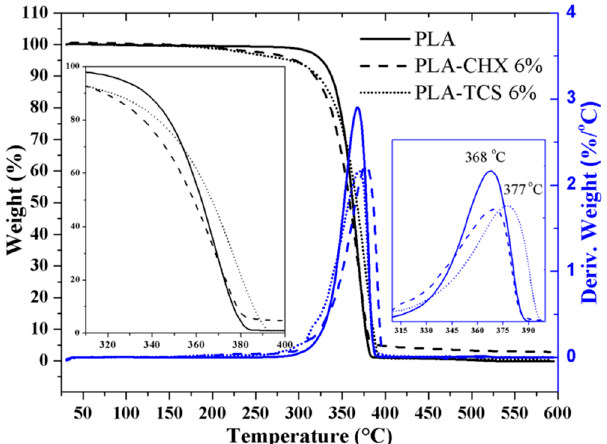
Figure 10. Thermogravimetric and differential thermogravimetric profiles of ultrasound processed specimens of PLA and PLA loaded with 6 wt-% of each drug. Magnification of onset temperature region and DTGA peaks are shown in the insets.